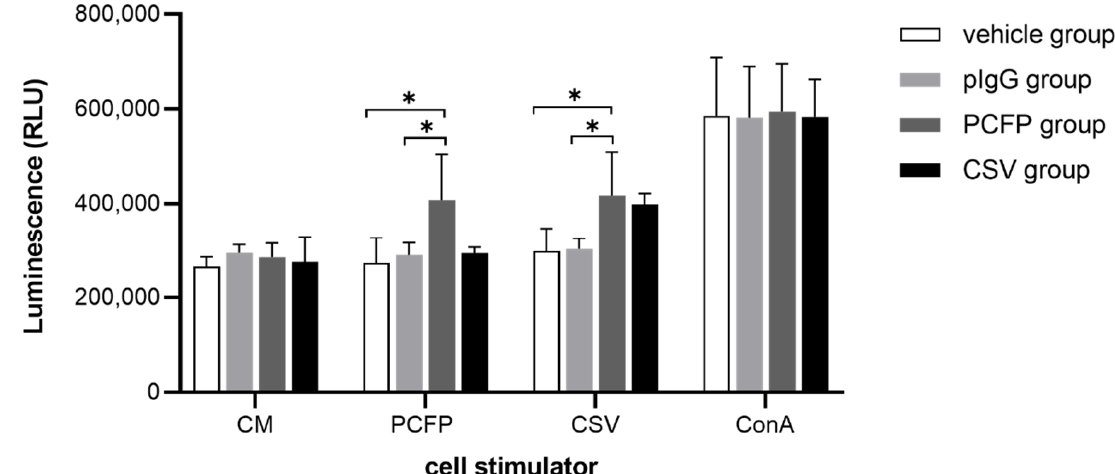
Figure 5. PCFP immunization elicited a specific lymphocyte proliferative response in an ex vivo splenocyte stimulation setting. Splenocytes from immunized mice were stimulated in vitro with the subunit vaccine CSV, PCFP fusion protein or ConA. Cell viability was measured after 72 h using Cell Titer Glo reagent. The data are shown as the mean ± SD, and were analyzed using Student’s t-test for comparisons between two groups. * p values < 0.05 were considered statistically signif- icant.